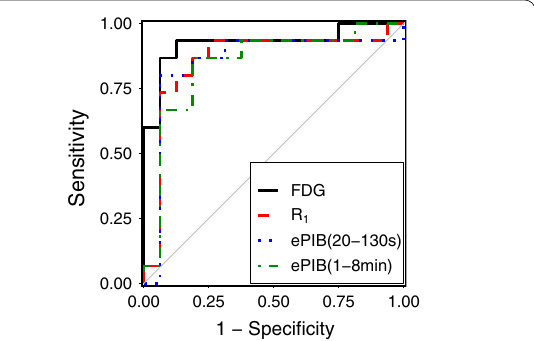
Fig. 3 ROC Plots . ROC plot with the curves of FDG (solid black line, AUC 0.93), R 1 (dashed red, AUC = AUC 0.69), and ePIB(1–8 min) (dot-dashed green, AUC =